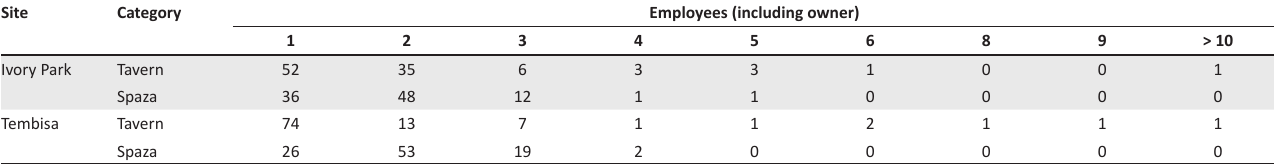
TABLE 6: Employment ( % within enterprise category).